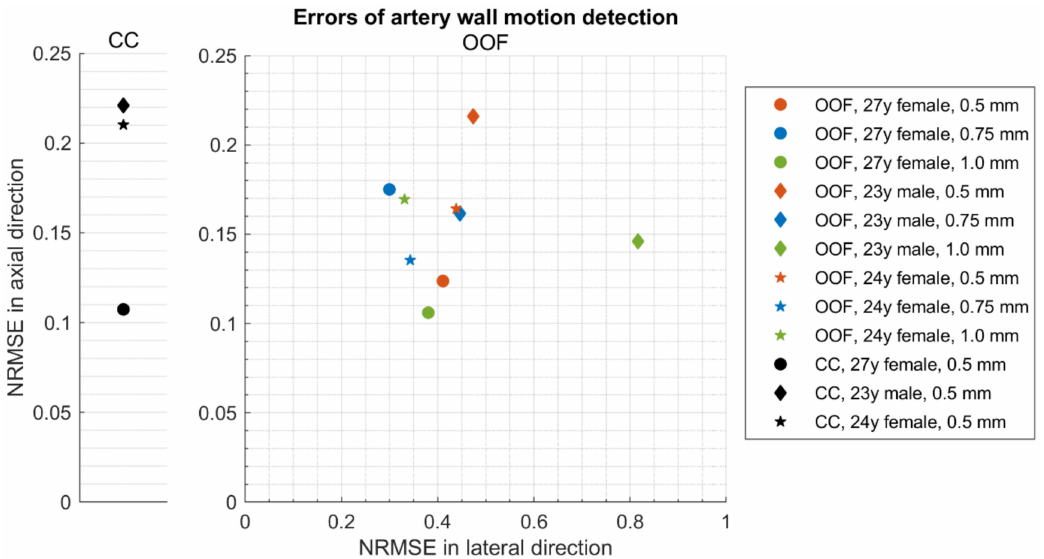
Figure 13. Medians of normalized root mean square errors (NRMSEs) between theoretically defined waveforms and estimated displacement waveforms in 3D motion models at axial positions from 14 to 15 mm and from 20 to 21 mm: 1DCC (see left part of the figure) and 2D OOF method (see right part of the